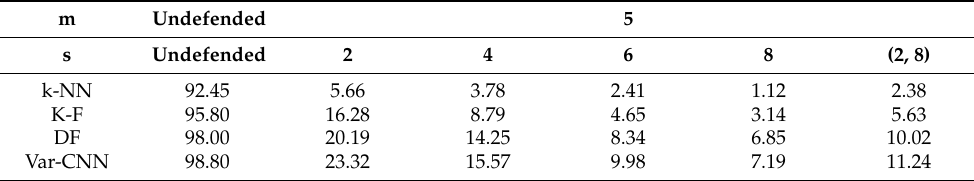
Table 3. The influence of a different number of slices and entry nodes on the classification accuracy. m Undefended